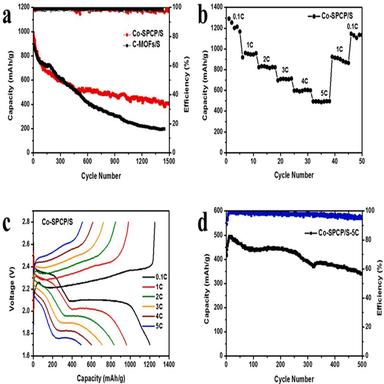
Galvanostatic charge-discharge curves with Coulombic efficiency of the Co-SPCP/S and C-MOFs/S cathodes at the rate of 1 C (a), rate capability test of the Co-SPCP/S electrode (b), and the corresponding charge/discharge potential profiles at a current density from 0.1 C to 5 C (c), galvanostatic charge-discharge curves with coulombic efficiency of the Co-SPCP/S cathodes at the rate of 5 C (d).